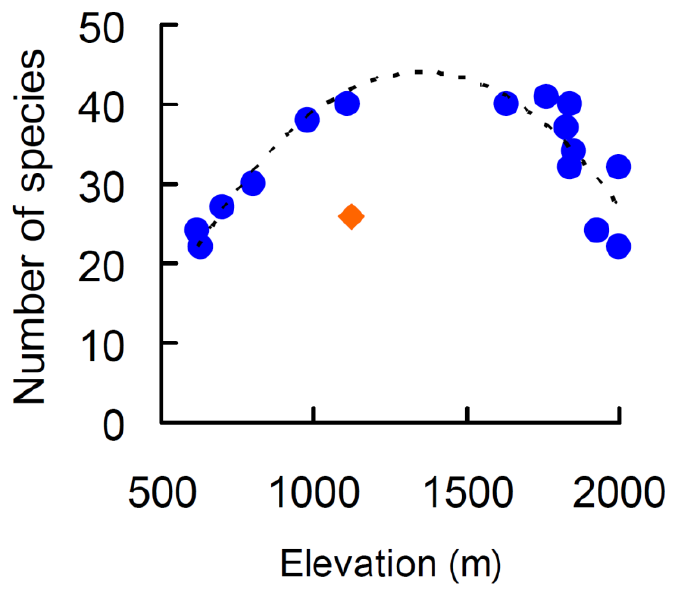
Figure 1. Relationship between plant species richness and elevation on a Central Apennine moun- tain (Mount Genzana) fitted with a parabolic model. Diamond indicates an outlier excluded from the